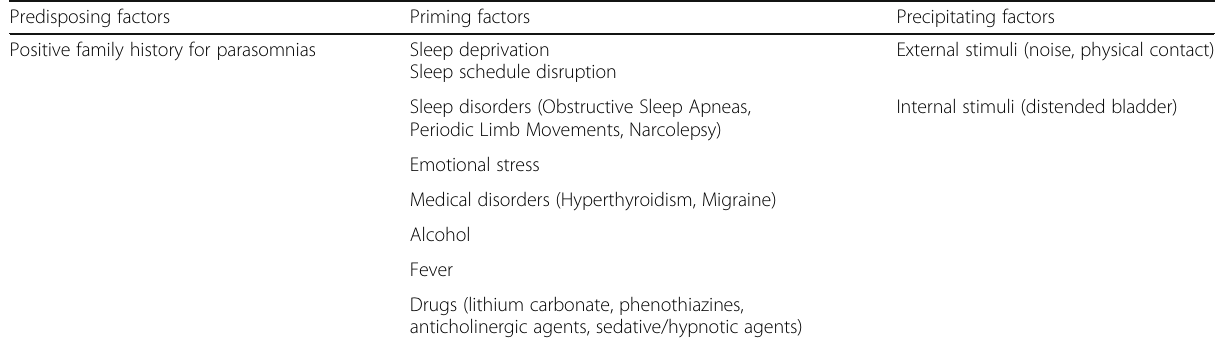
Table 1 Predisposing, priming, and precipitating factors of Disorders of Arousal (DOA)